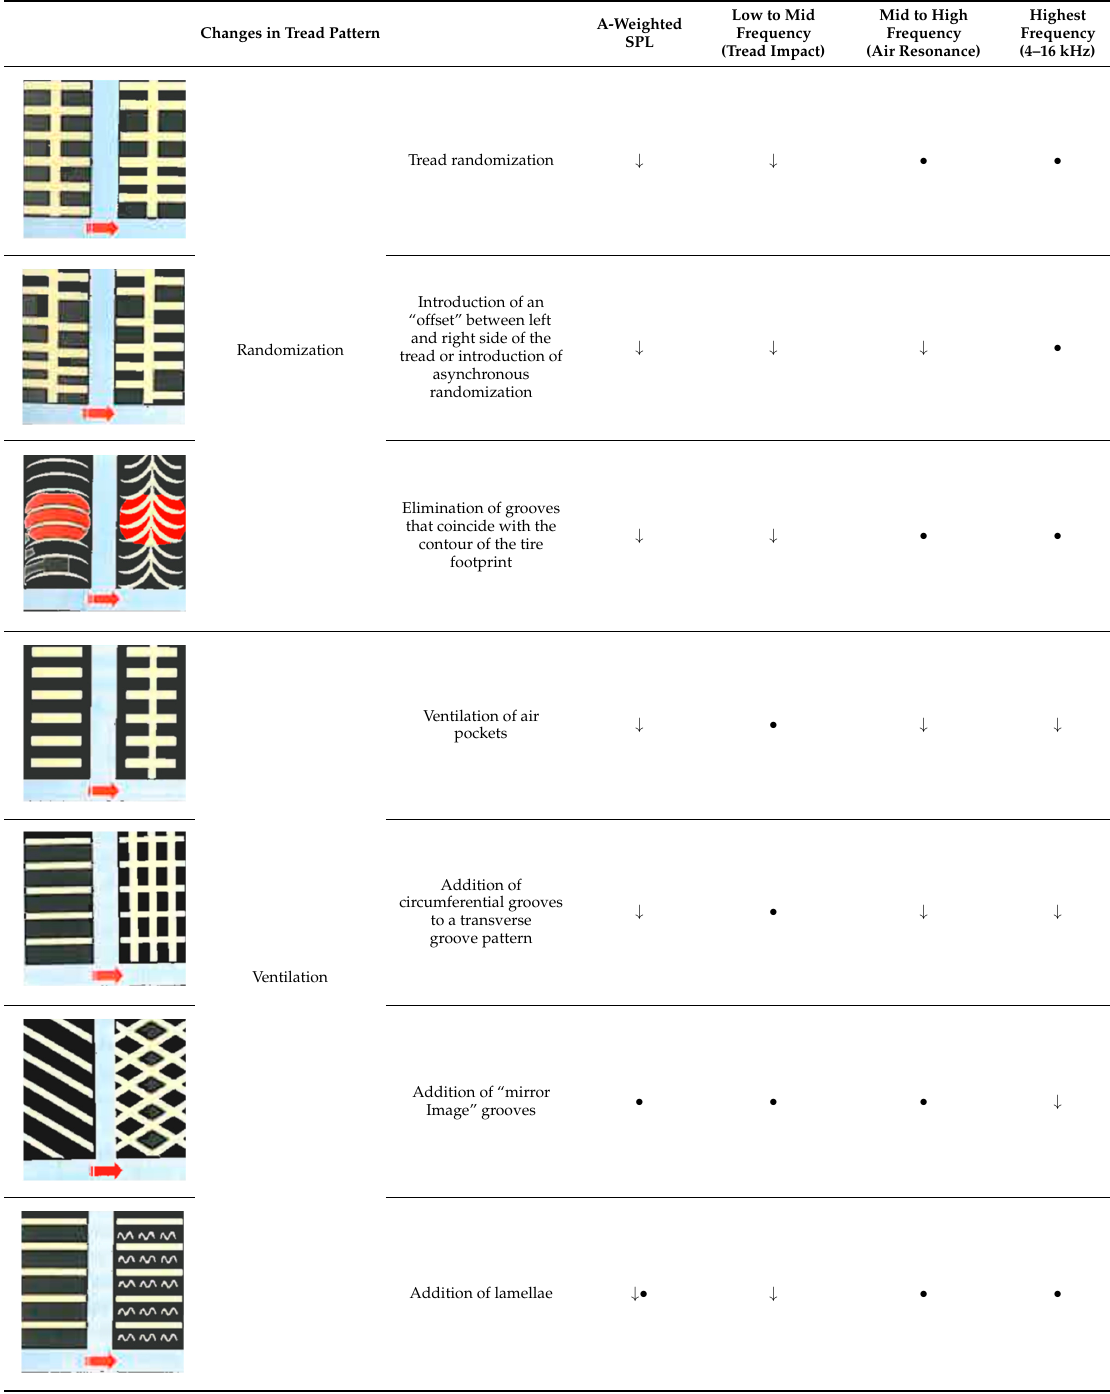
Table 7. General influence of tread pattern on TPIN (source from Sandberg and Ejsmont, 2002 [1], Table 10.3; reprinted with permission from Dr. Ulf Sandberg of VTI, Sweden) ( ↑ denotes increase; • denotes no influence; ↓ denotes decrease).